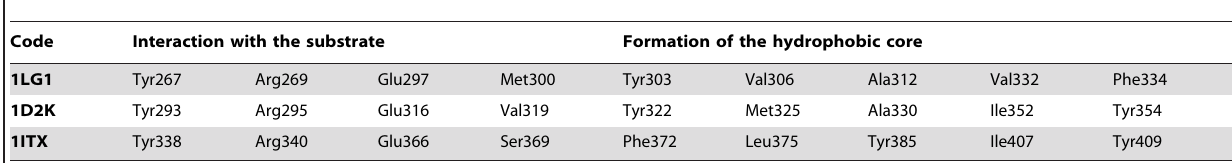
Table 1. Conserved residues on the CIDs in chitinases denoted by PDB codes of 1LG1, 1D2K, and 1ITX and their proposed roles.